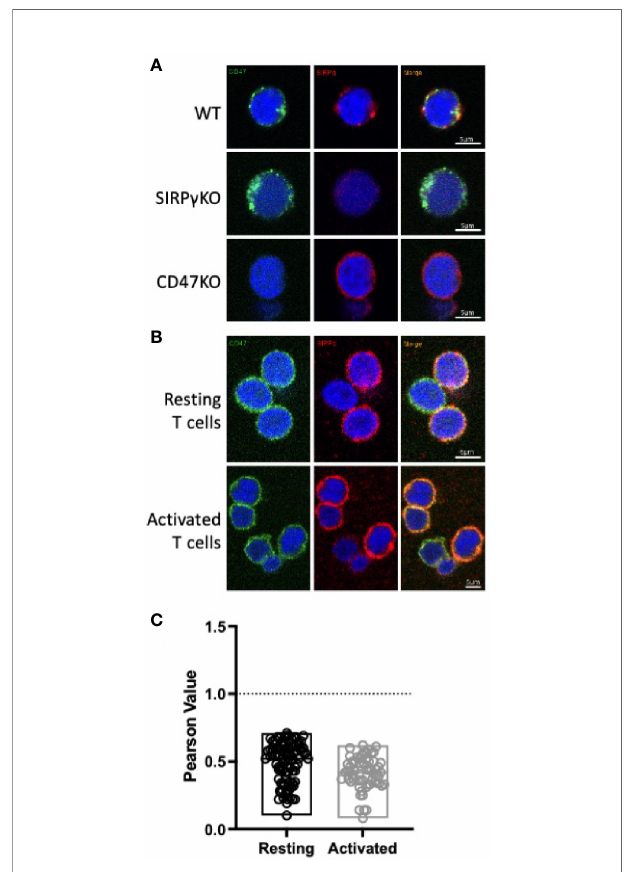
FIGURE 3 | CD47 and SIRP g do not colocalize on T cells. (A, B) Confocal microscopy imaging showing SIRP g (red) and CD47 (green) cell surface distribution on Jurkat T (A) , freshly isolated T cells ( B , upper panel) and activated T cells [ (B) , lower panel]. Nuclei are stained with DAPI (blue). Images were taken with ×60 and ×2 zoom. (C) Colocalization of SIRP g and CD47 on resting vs . activated T cells was investigated using ImageJ software and coloc2 plugin. Pearson value comprising between 0 (no colocalization) and 1 (colocalization) is presented for resting and activated T cells. n = 2 independent